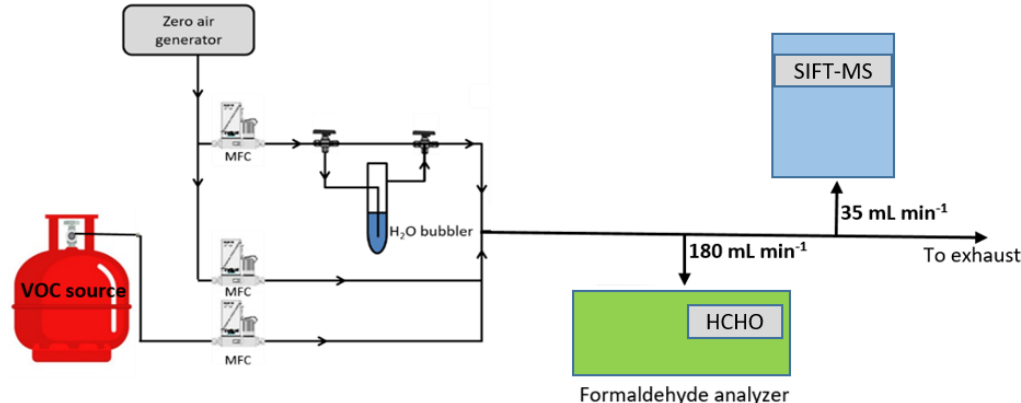
Figure 1. Experimental setup used in the framework of the current study.